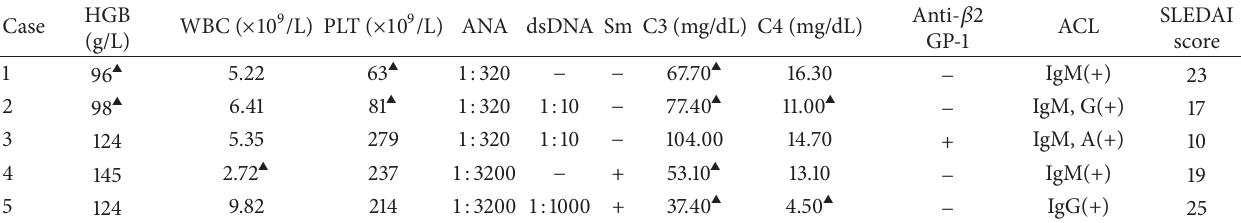
Table 1: Laboratory test results of SLE that has nephritis with mainly IgA deposits.